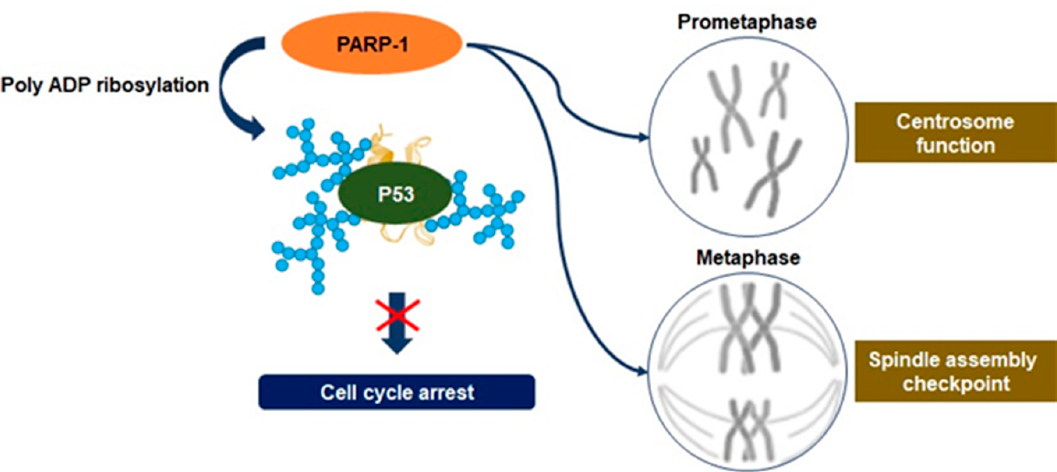
Figure 5. Regulation of mitosis by PARP-1. Defects in chromosome segregation during mitosis can lead to many aneu- ploidies, and upstream regulation of irregulated chromosome numbers can upregulate the proliferation of cancer cells. PARP-1 regulates the function of the centrosome to control spindle assembly checkpoints in cancer cells, and it may result from excessive poly ADP ribosylation on the tumor suppressor gene p53. PARP-1 is accumulated in centrosome chromatin during mitotic metaphase and can modify spindle assembly checkpoints, leading to aneuploidy. These activities have a role in promoting tumorigenesis of pancreatic cancer cells via aneuploidy-induced delaminating properties.